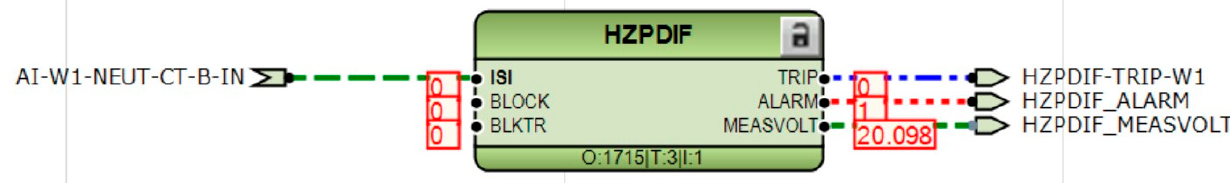
Figure 10. Measured protection operation and voltage by relay logic software ABB-PCM 600 after the stability test.